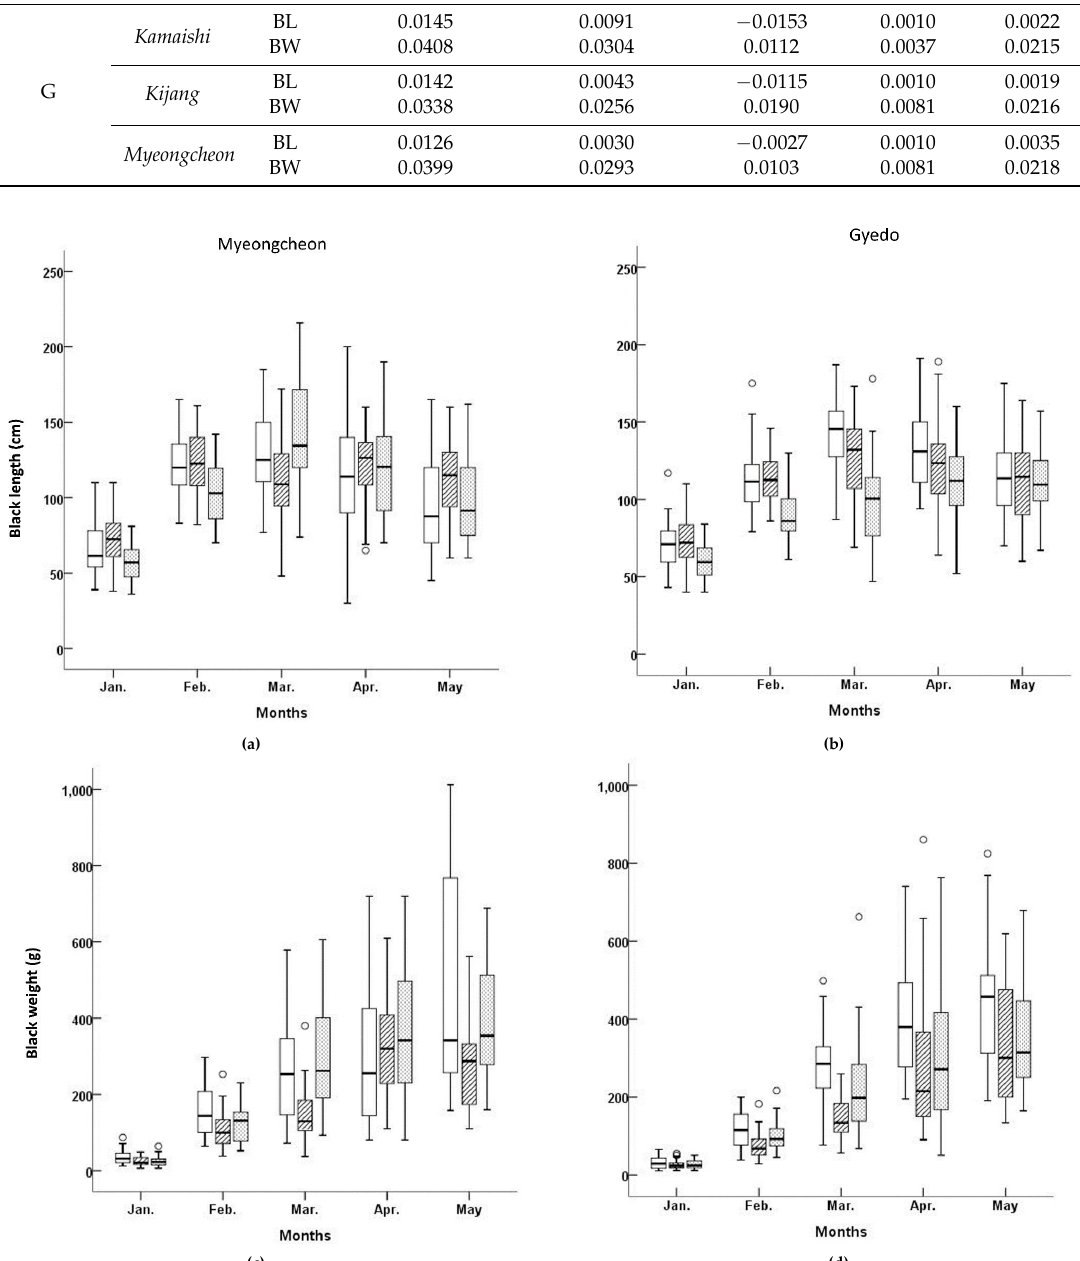
Diversity 2018 , 10 , x FOR PEER REVIEW 5 of 11 Figure 2. Box plots of blade lengths and blade weights for three Undaria pinnatifida cultivars at Figure 2. Box plots of blade lengths and blade weights for three Undaria pinnatifida cultivars at Figure 2. Box plots of blade lengths and blade weights for three Undaria pinnatifida cultivars at Figure 2. Box plots of blade lengths and blade weights for three Undaria pinnatifida cultivars at Myeongcheon and Gyedo aquafarms between January Myeongcheon and Gyedo aquafarms between January and May 2003. □ , ‘ Kamaishi ’ cultivar; ▨ , and May 2003. □ , ‘ Kamaishi ’ cultivar; ▨ , ‘ Kijang ’ cultivar; ▓ , ‘ Myeongcheon ’ cultivar. Myeongcheon and Gyedo aquafarms between January and May 2003. □ , ‘ Kamaishi ’ cultivar; ▨ , Myeongcheon and Gyedo aquafarms between January and May 2003. (cid:3) , ‘ Kamaishi ’ cultivar; ‘ Kijang ’ cultivar; ▓ , ‘ Myeongcheon ’ cultivar. ‘ Kijang ’ cultivar; ▓ , ‘ Myeongcheon ’ cultivar. Table 2. Mean, median, standard deviation (SD), standard error (SE), coefficient of variation (CV), Table 2. Mean, median, standard deviation (SD), standard error (SE), coefficient of variation (CV), maximum (Max), and minimum (Min) values of blade lengths (BL), and blade widths (BW) for three maximum (Max), and minimum (Min) values of blade lengths (BL), and blade widths (BW) for three cultivars of U. pinnatifida at Myeongcheon (M) and Gyedo (G) aquafarms between January and May cultivars of U. pinnatifida at Myeongcheon (M) and Gyedo (G) aquafarms between January and May 2003.